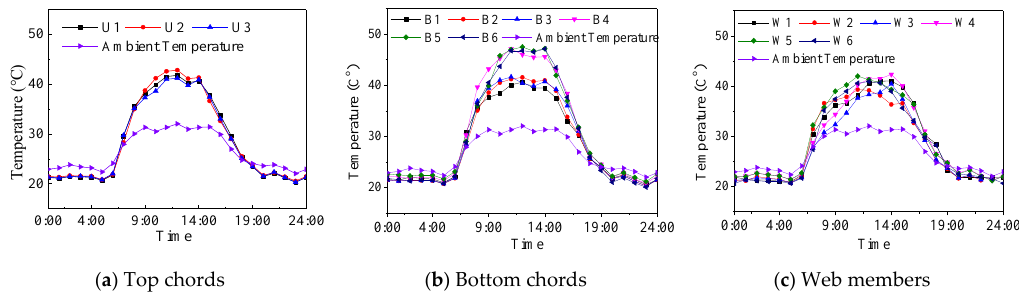
Figure 5. The temperature variation curves of different structural members.